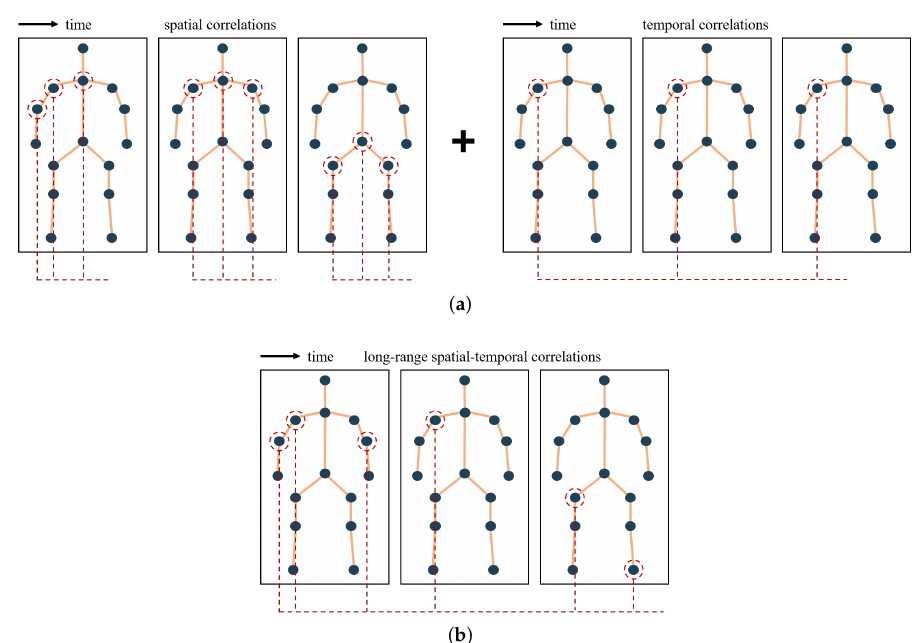
Figure 1. The method for capturing spatial-temporal correlations for skeleton graphs. Previous GCNs adopted a spatial-temporal cascaded backbone to learn their representations. However, the trans- former architecture is able to capture the long-range correlations for skeleton graphs. ( a ) Cascaded spatial-temporal correlations via GCNs. ( b ) Long-range spatial-temporal correlations via